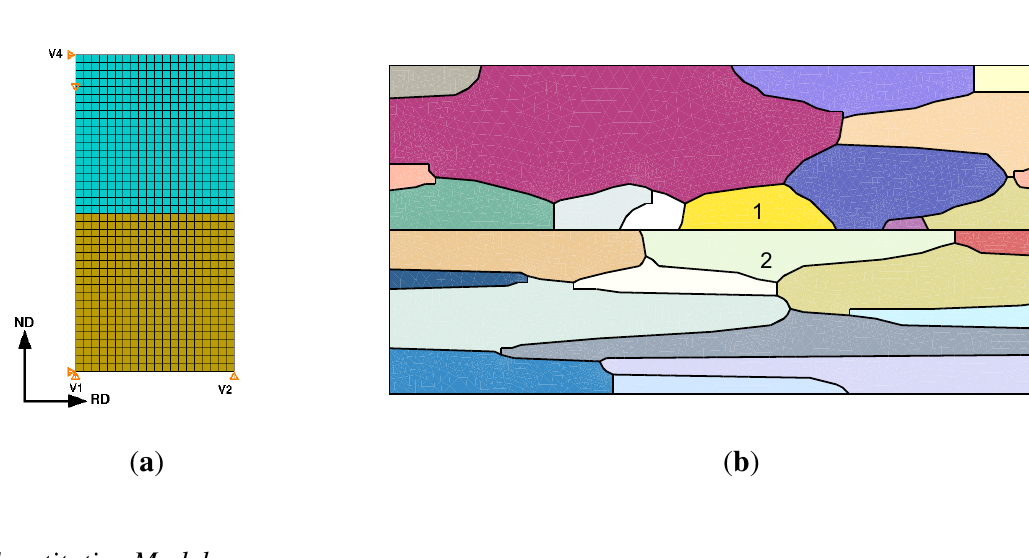
Figure 1. Finite element models: ( a ) periodic bicrystal; and ( b ) multicrystal grain